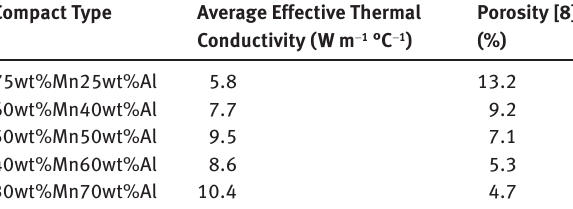
Table 3: Average effective thermal conductivities and porosities of various Mn-Al compacts